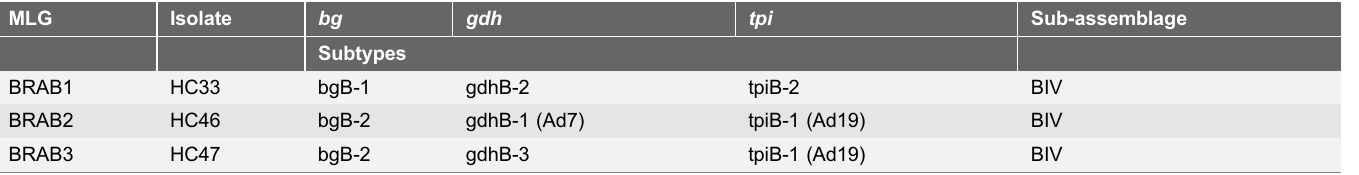
Table 6. Multilocus genotypes (MLGs) in G. duodenalis assemblage B isolates.